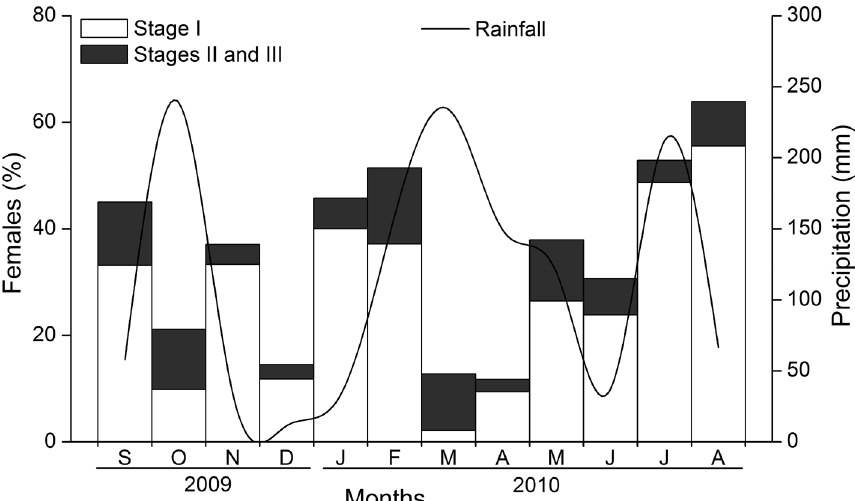
Figure 9. Monthly changes in the percentage occurrence of Palaemon pandaliformis female with non-eye (Stage I) and eyed eggs pig- mentation (Stage II and III), and precipitation recorded from September 2009 and August 2010 in Rio Salsa, Canavieiras, Bahia,